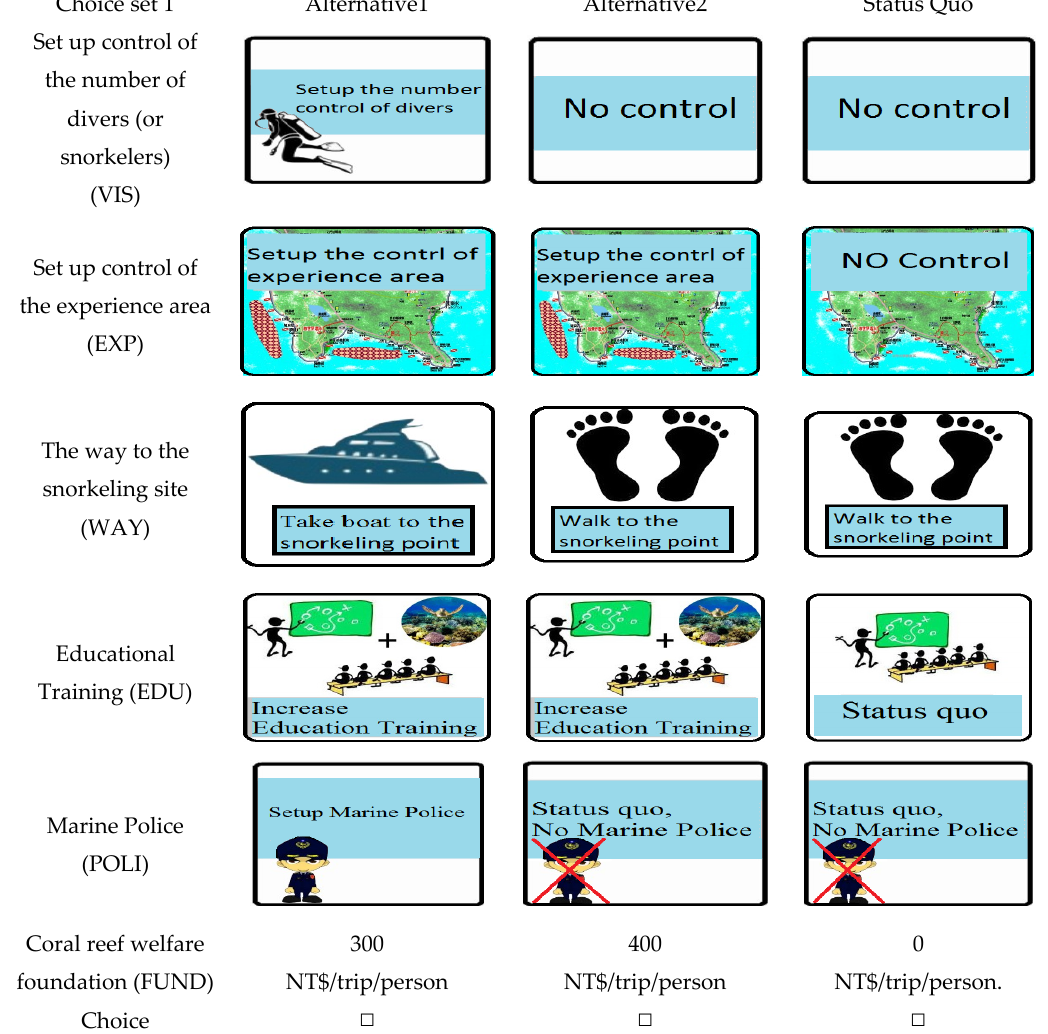
Figure 3. An example of a choice set for the reef impact reduction program in the reef recreational